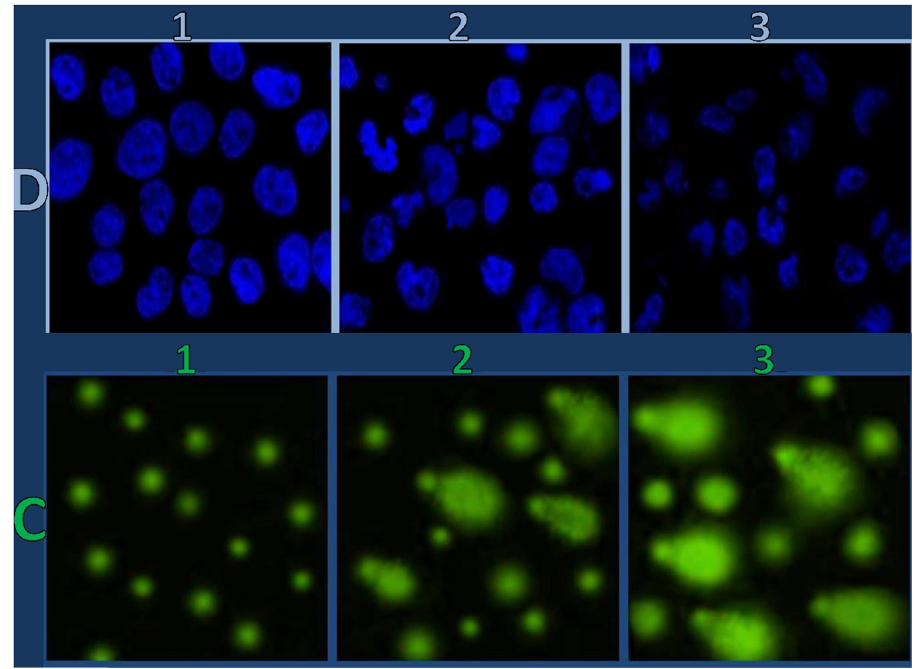
Figure 5: Fluorescent imaging of treated HT - 29 cancerous cells with Fu/Re ( 2 ) and Fu/Re/SeNPs ( 3 ) composites, compared to untreated cells ( 1 ) using DAPI staining ( D ) and comet assay ( C )